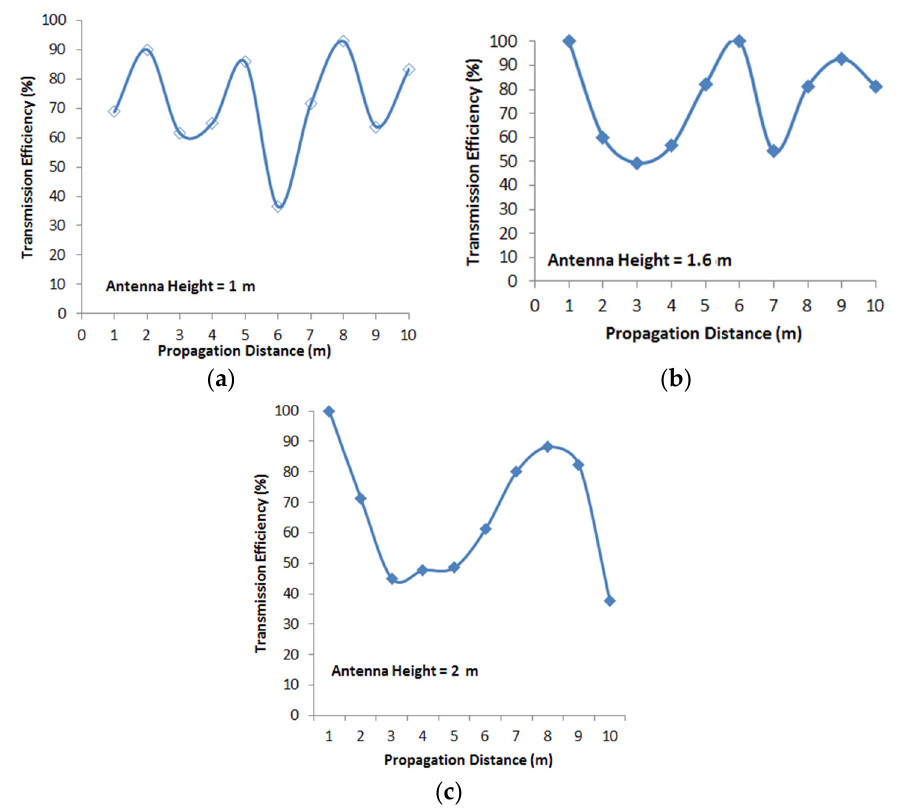
Figure 5. Transmission efficiency as a function of transmission distance: ( a ) when the antenna height was 1 m; ( b ) when the antenna height was 1.6 m; ( c ) when the antenna height was 2 m.